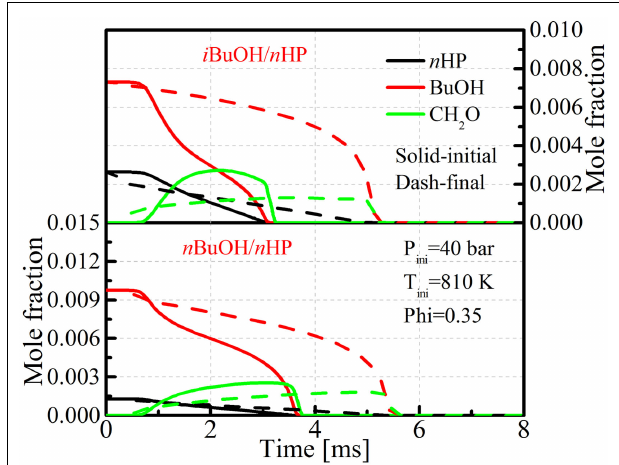
FIGURE 1 | Evolution of butanol, n -heptane, and CH 2 O in adiabatic homogeneous constant volume reactor simulations for base and updated mechanisms